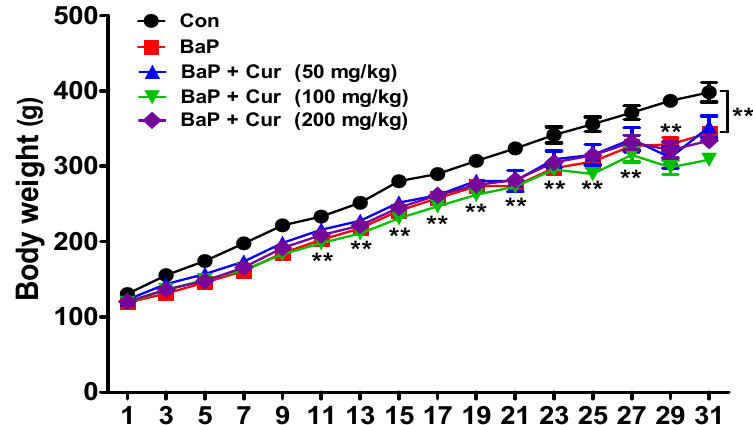
Figure 1. E ff ects of curcumin on body weight changes in rats treated with benzo(a)pyrene. Rats were orally administrated benzo[a]pyrene (BaP) alone (20 mg / kg) or in combination with curcumin (50, 100, or 200 mg / kg) for 30 days. The control group was administered vehicle only. Values are indicated by mean ± SEM of six animals. Significant di ff erence from the control group at ** p < 0.01. Cur: curcumin. Table 1. E ff ects of Curcumin on Organ Weight Changes in Sprague-Dawley Rats. Groups